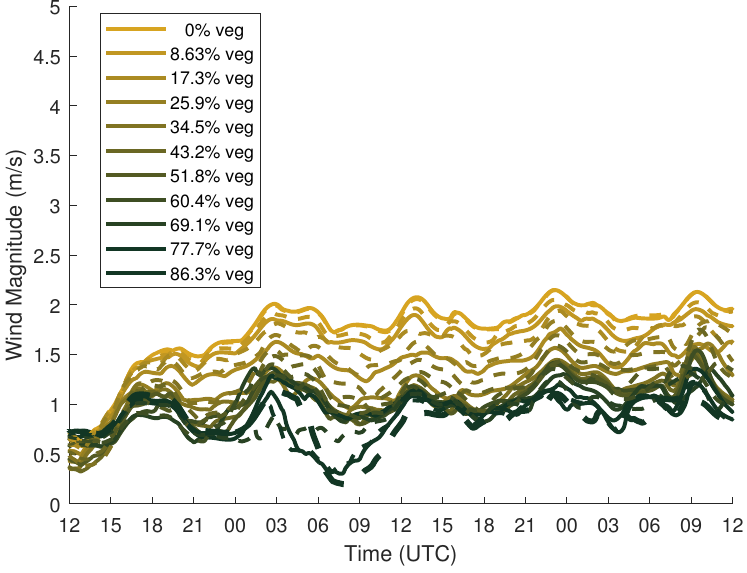
Figure 13. Time evolution of wind speed for the 18 October 2014 case at 117 m for each vegetation percentage. Solid lines denote the experiments using the multilayer SBL scheme and the dashed lines denote the experiments using the single layer